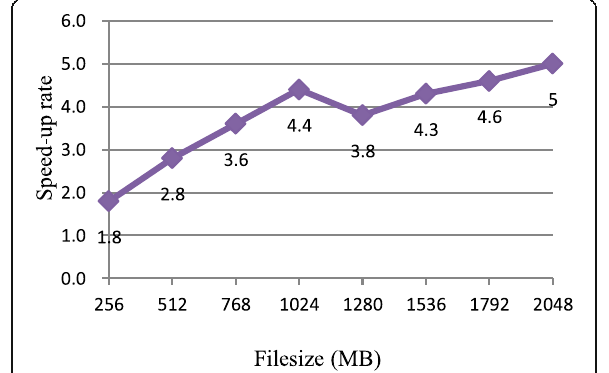
Fig. 3 The speed-up rate of different size file. The figure shows the overall speed-up rate under different file sizes in parallel